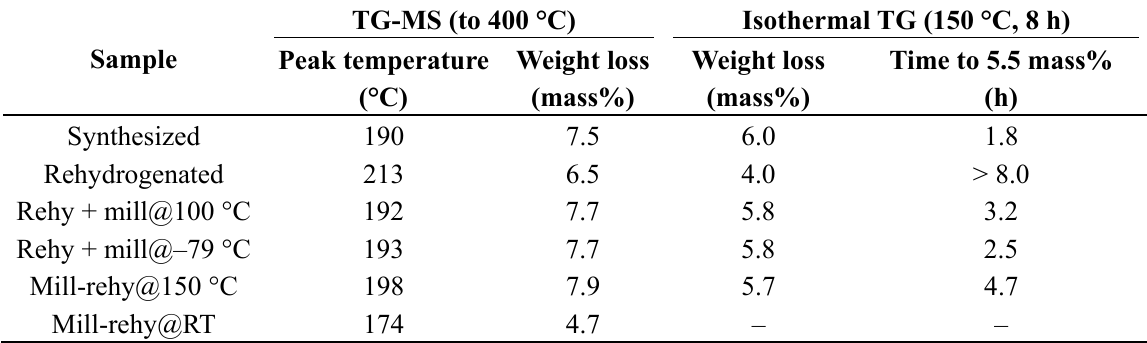
Figure 5. TG-MS profiles of the 8LiH-3Mg(NH 2 ) 2 samples after the synthesis, the thermochemical rehydrogenation, and the ball-milling at 100 °C and − 79 °C for the rehydrogenated sample. Table 1. Peak temperature and weight loss obtained by TG-MS to 400 °C, weight loss obtained by isothermal TG measurements at 150 °C for 8 h, and time required to desorb 5.5 mass% of hydrogen at 150 °C of each